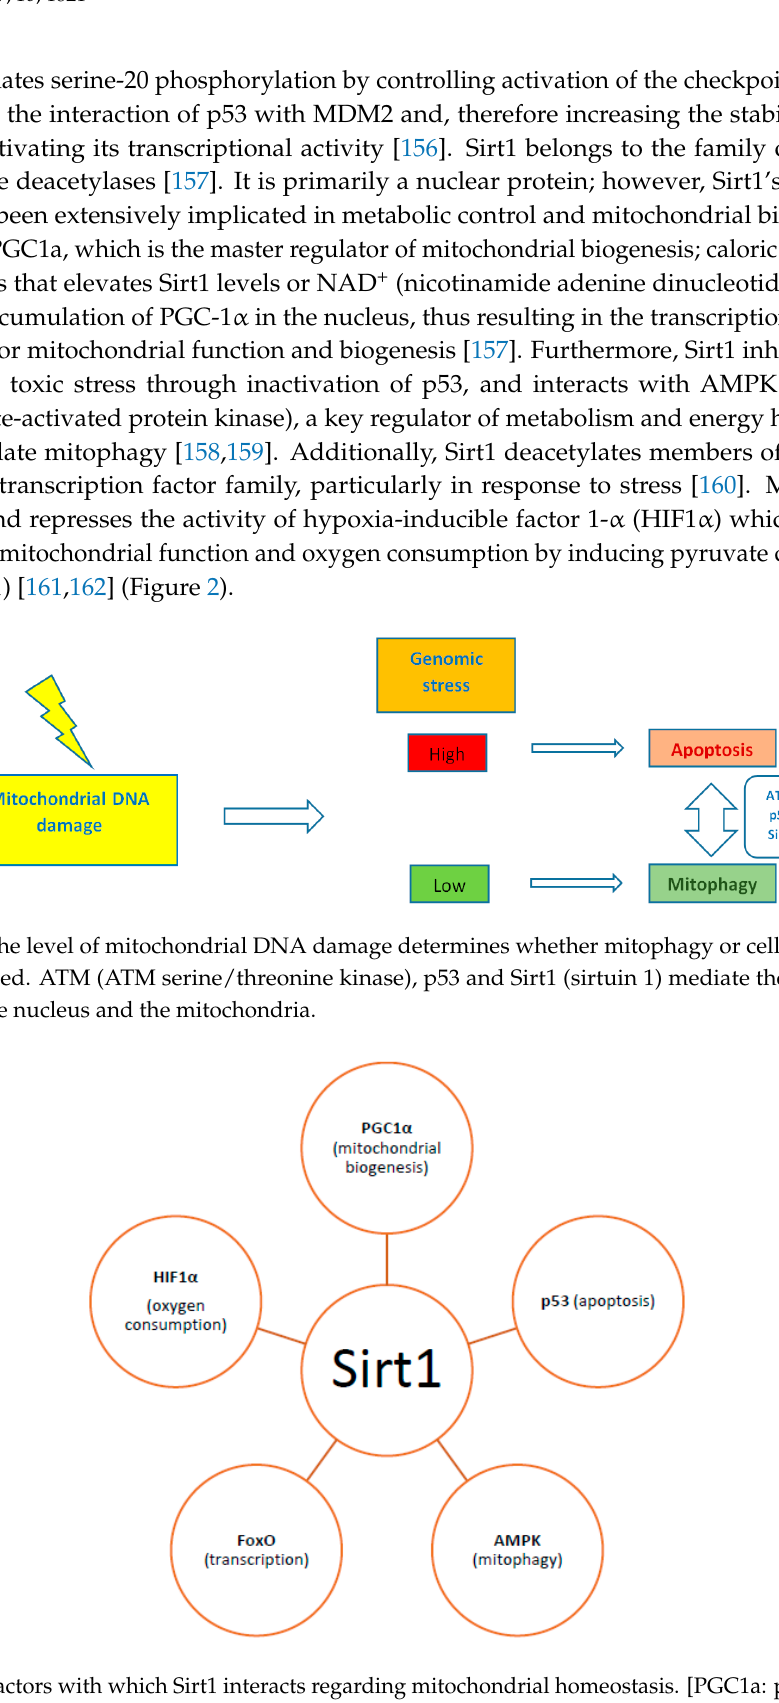
Figure 2. Factors with which Sirt1 interacts regarding mitochondrial homeostasis. [PGC1a: peroxisome proliferator-activated receptor gamma co-activator (PGC1a), HIF1a: hypoxia-inducible factor 1-alpha, AMPK: 5’ adenosine monophosphate-activated protein kinase].